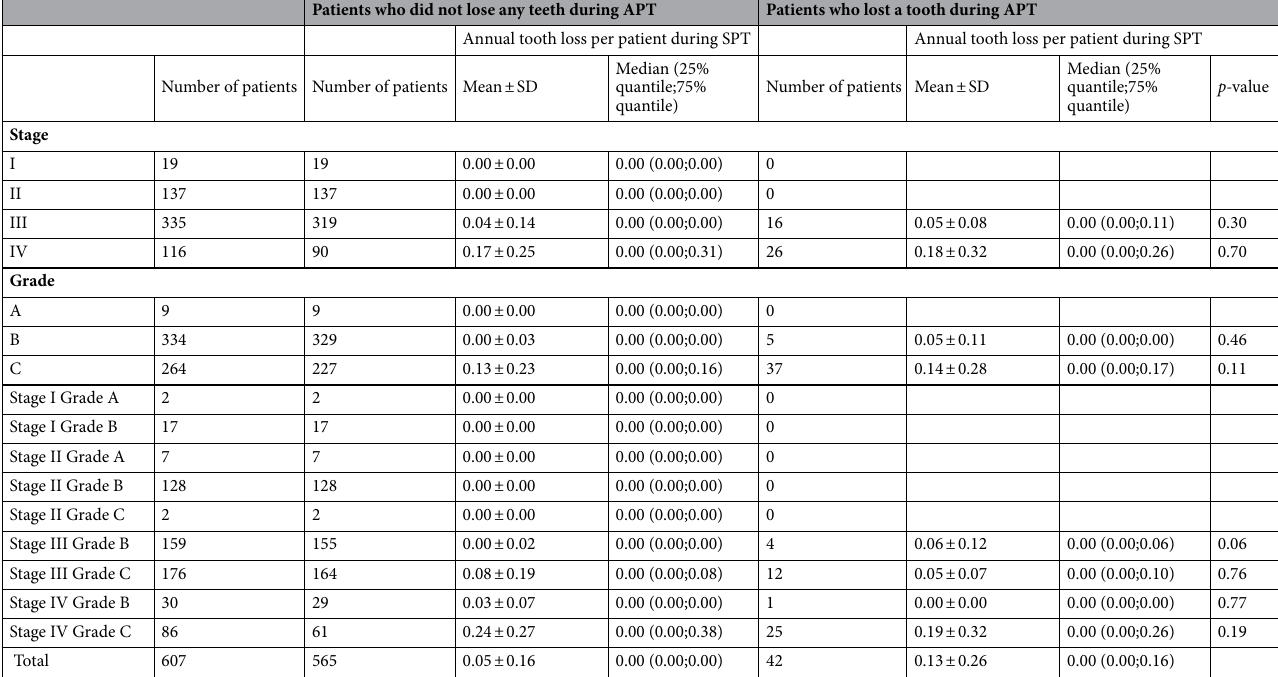
Table 4. Annual tooth loss per patient during SPT with or without tooth loss during APT. Statistical analysis was performed with the Mann–Whitney U test. Tooth loss per patient is shown as mean ± standard deviation. APT active periodontal therapy; SPT supportive periodontal